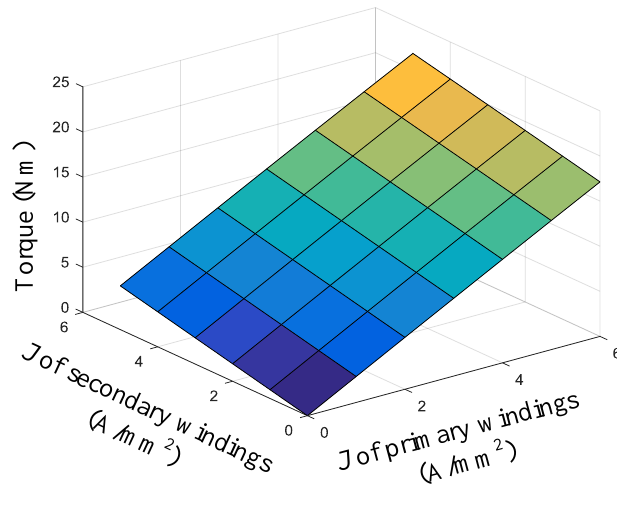
Figure 15. Torque-current curve.